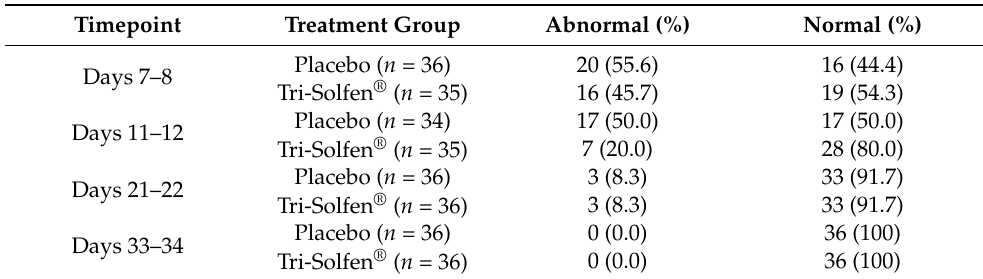
Table 6. Proportions of normal versus abnormal disbudding wounds in animals between treatment groups and over time for Study